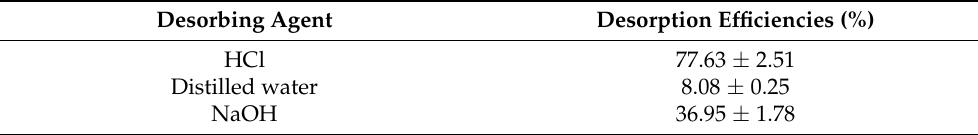
Figure 8. Correlation of experimental and predicted dye removal efficiency. Table 7. The efficiencies of the used desorbing